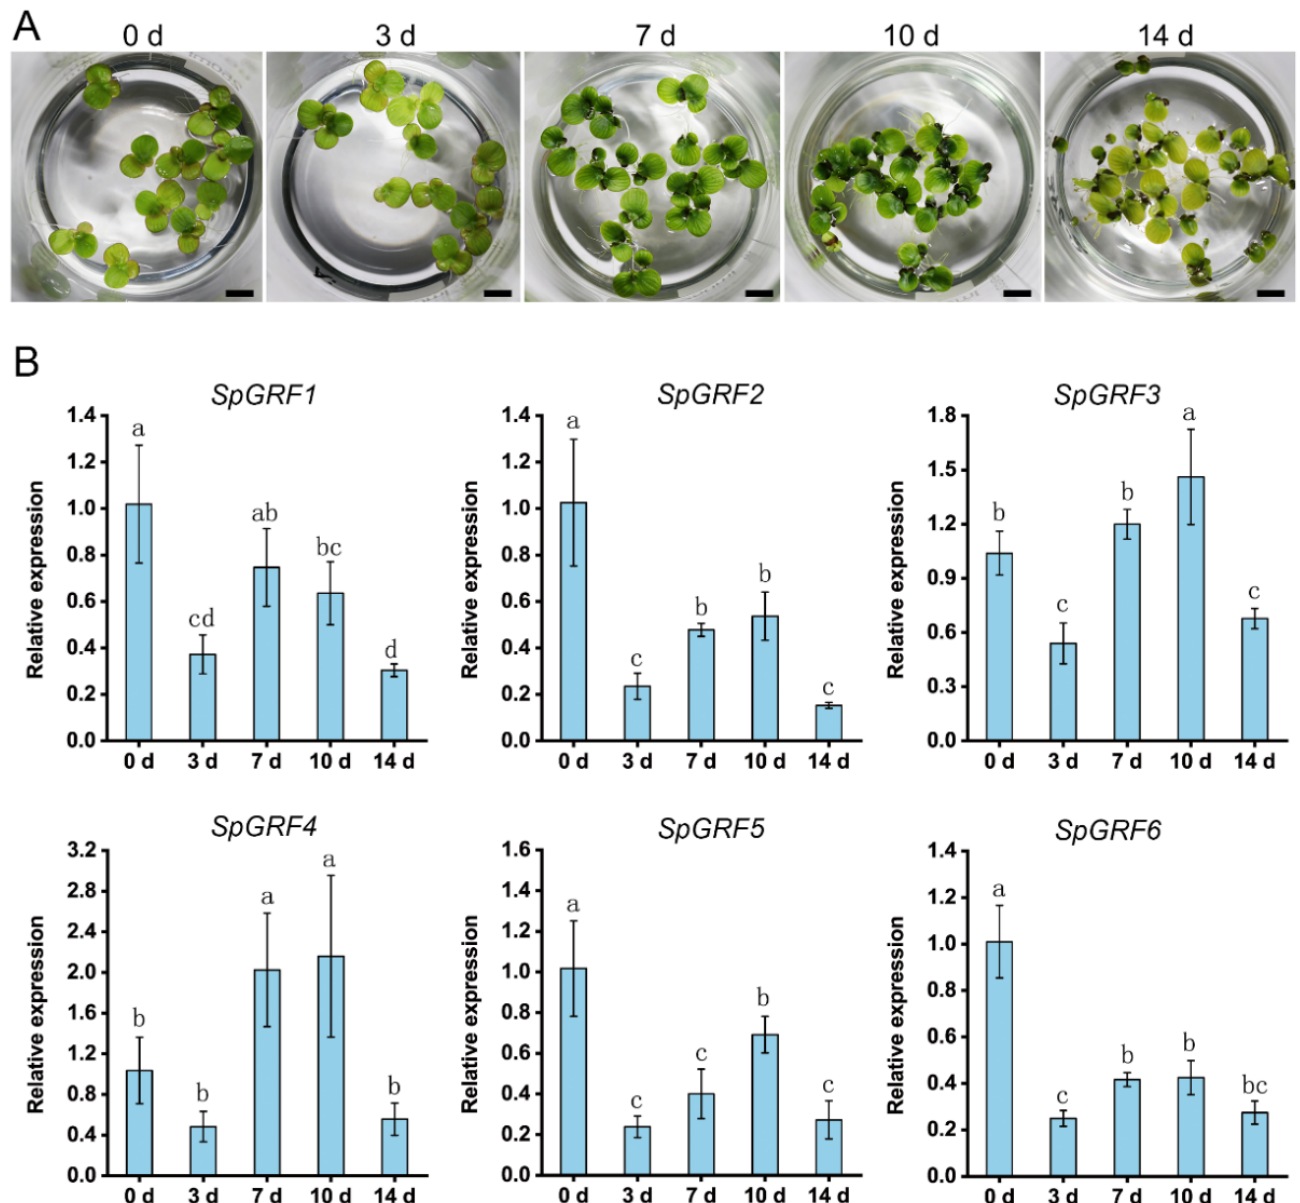
Figure 9. Phenotypes and expression of the SpGRFs during the ABA-induced turion formation of S. polyrhiza . ( A ) Phenotypes of S. polyrhiza during the ABA-induced turion formation. Bars = 1 cm. ( B ) Expression of the SpGRFs in the fronds after the treatment. The different letters indicate statistically significant differences relative to 0 days, as determined by the Duncan test ( p < 0.05).